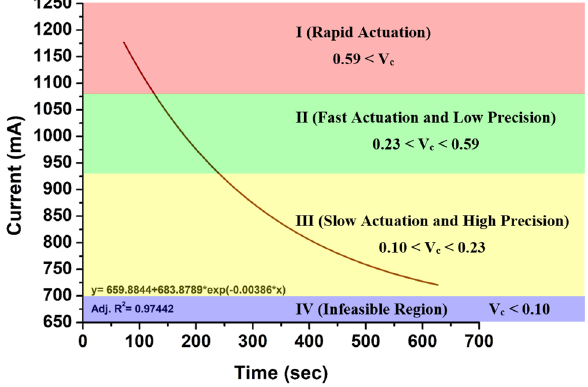
Fig. 1 Exponential plot of current vs. time for contraction of pre- stretched nitinol spring